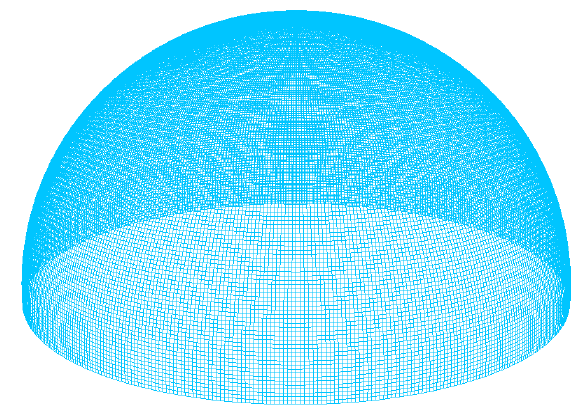
Figure 5 Schematic diagram of view space and projection surface